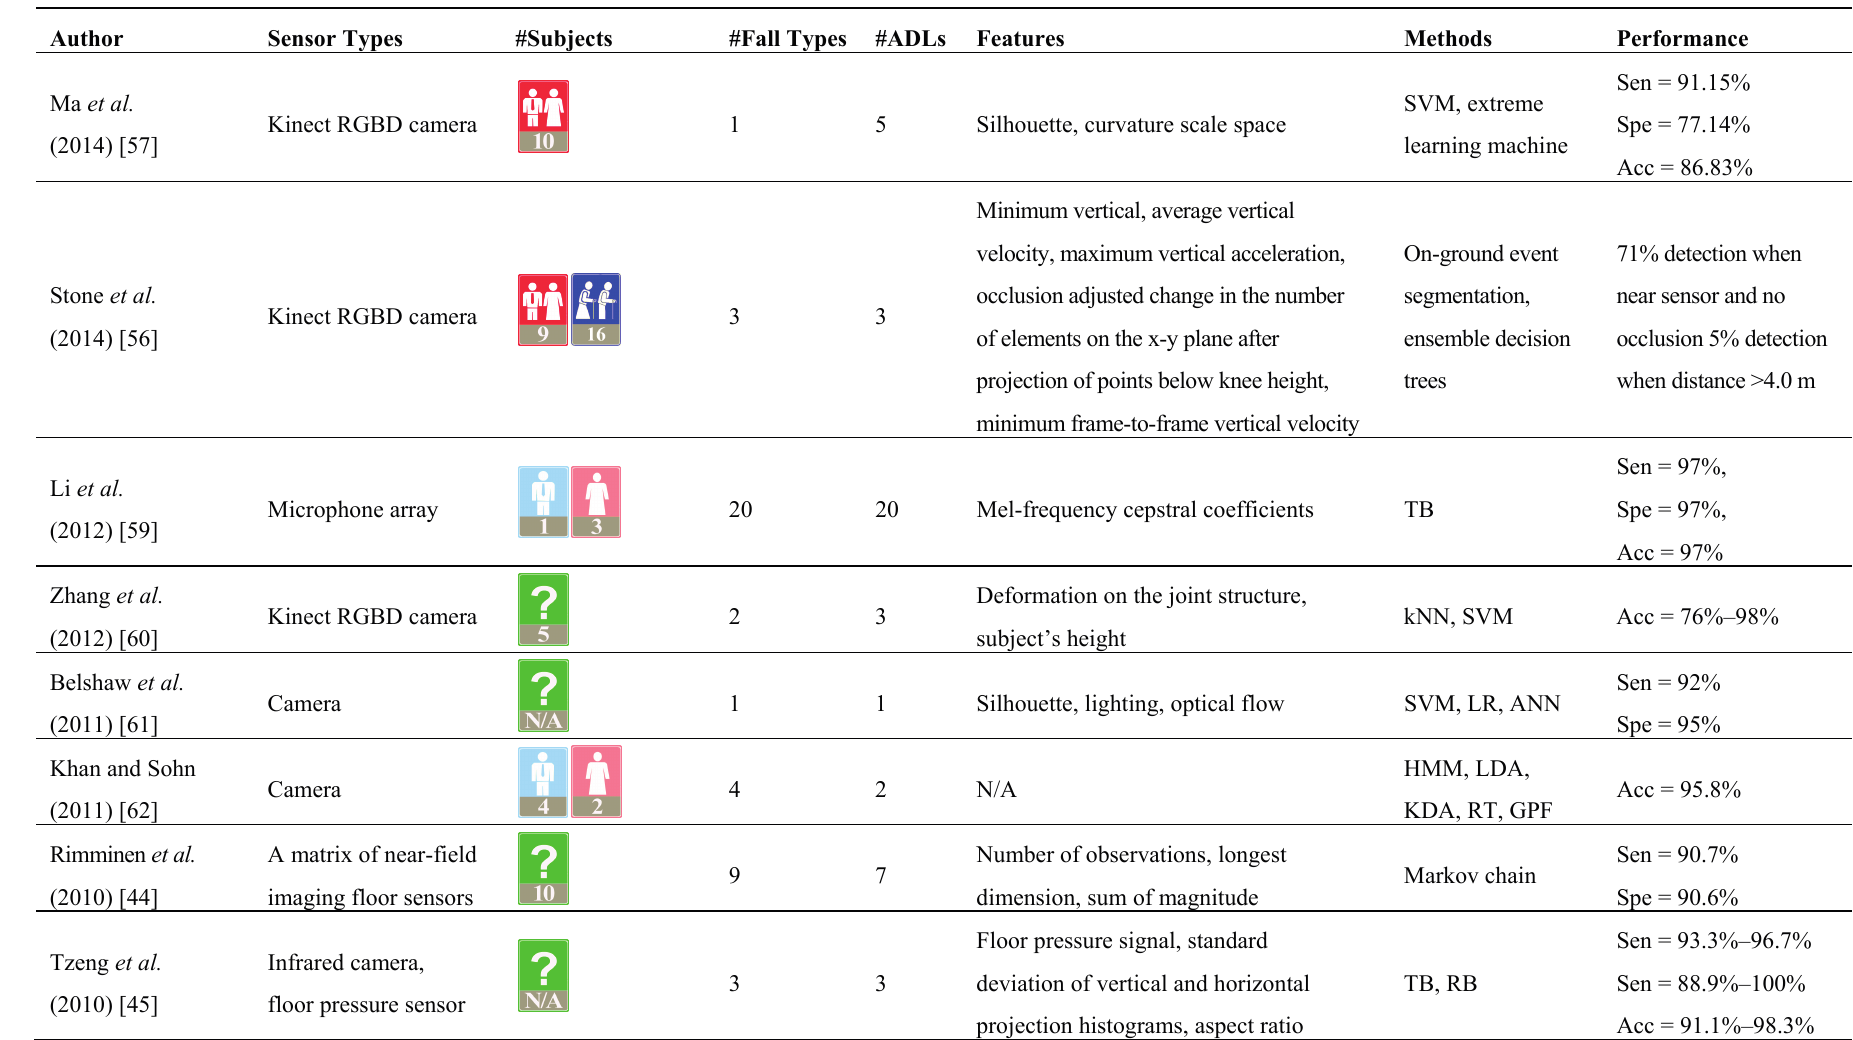
Table 1. Ambient-sensor-based fall detection